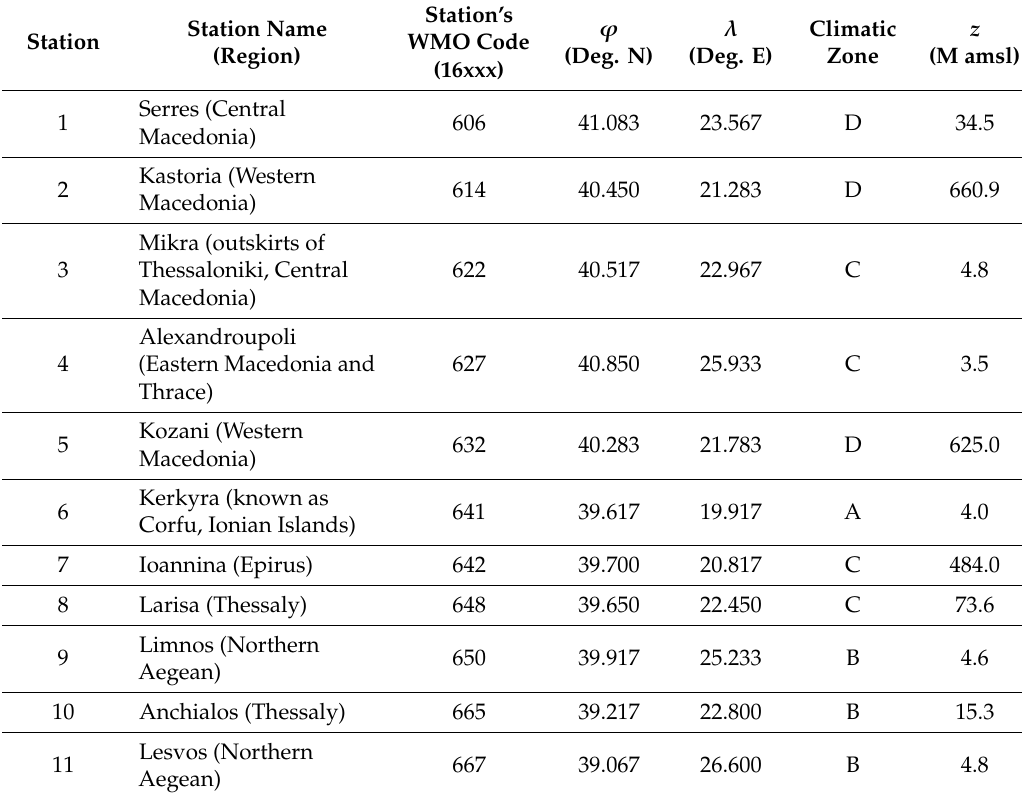
List of the meteorological HNMS stations used in this